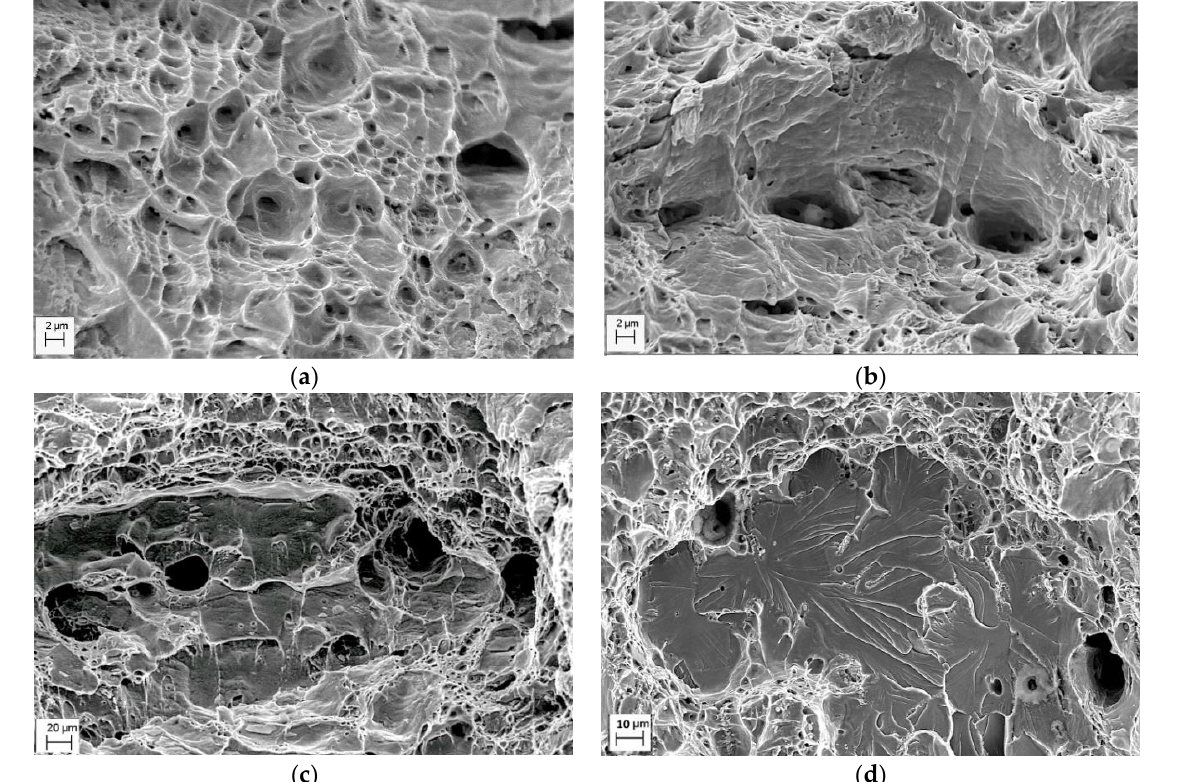
Figure 5. Typical fracture surfaces of pipeline steels after the Charpy testing: X70 ( a , b ) and 17H1S ( c , d ) in the as-received state ( a ) and after operation for 37 years ( a ), 30 ( c ), and 51 ( d ) years.